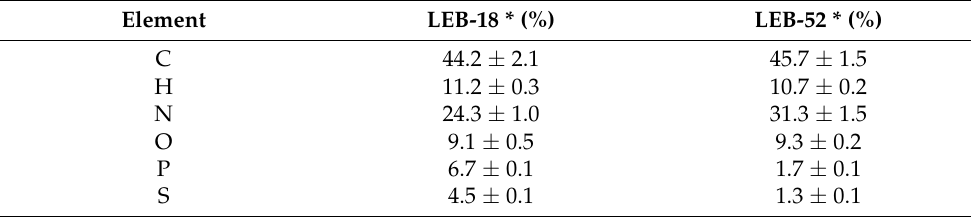
Table 2. Elemental composition of LEB-18 S. platensis and LEB-52 S. platensis biomasses.